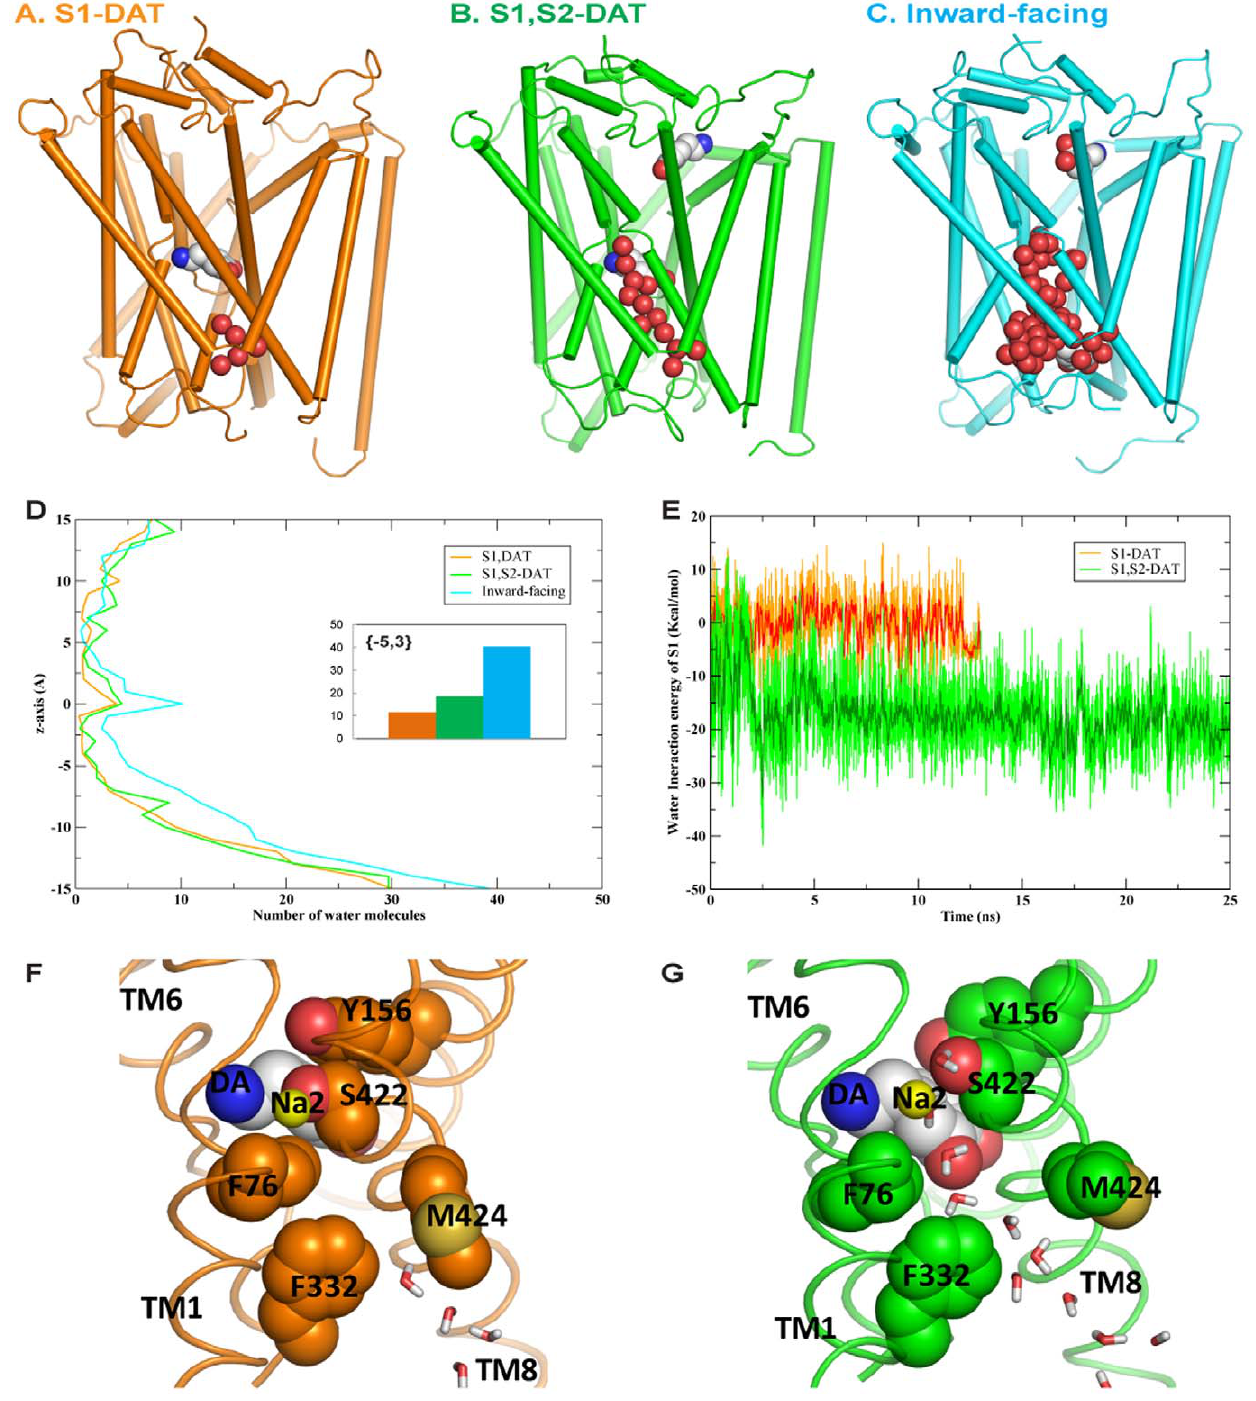
Figure 3. The S2-induced transition of DAT to an inward-open conformation is accompanied by water penetration. ( A , B , C ) Waters (red balls) gradually penetrate to the S1 site, during the transition from S1-DAT ( A ) to S1,S2-DAT ( B ), then to the inward-facing conformation ( C ). ( D ) Average number of waters along the membrane normal (the z-axis; z=0 is at the center of the membrane) in ( A )–( C ). The insert shows waters accumulated between 2 5 A˚ and + 3 A˚ (z-axis) in the corresponding models identified by the colors. ( E ) DA in the S1 site interacts more favorably with waters in the presence of a substrate in the S2 site (green) than in the absence of a substrate in the S2 site (orange). ( F ) and ( G ) show magnified details of ( A ) and ( B ), respectively, with the same color coding and water in stick representations. doi:10.1371/journal.pone.0016350.g003 unwound region) remain largely unchanged, whereas the TM1a moves substantially more, thereby distancing itself from intracellular ends, TMs1a and 6b, swing outward non- TM6b (Figure 5C). Consistent with the mechanism proposed from symmetrically to open the substrate translocation pathway. the crystal structure of LeuT [15], we did not observe a big